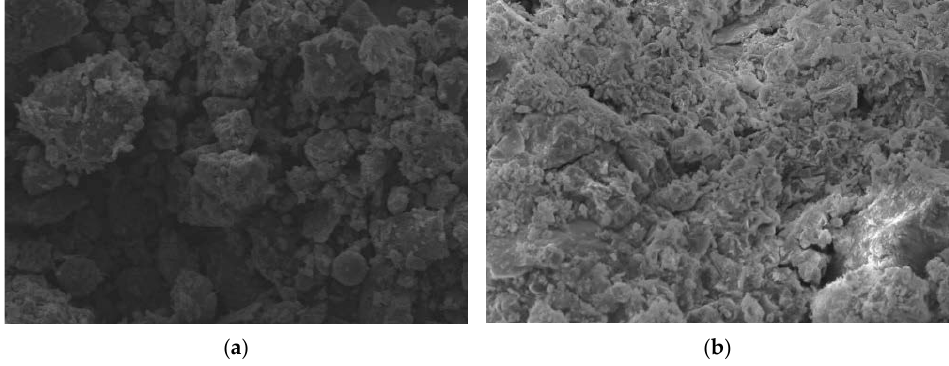
Figure 9. SEM images (500 times). ( a ) Undisturbed shield mud; ( b ) Group G test block.